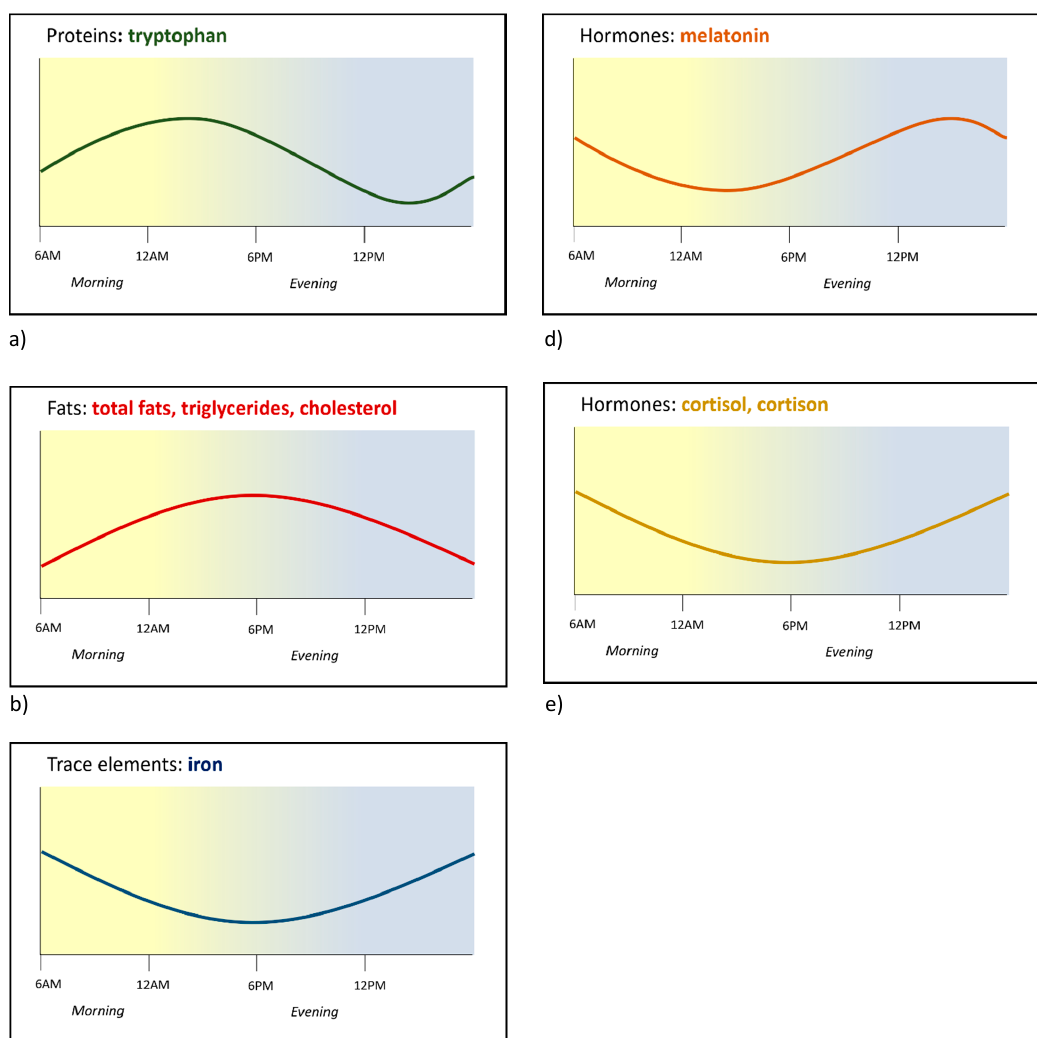
Figure 2. Circadian variation in human milk components. Schematic presentation of estimated circadian curves based on peak and trough values reported in the literature. Circadian variation curves are shown for the following components: ( a ) tryptophan [18,43], ( b ) total fats, triglycerides, cholesterol [25,32,47,48,50–53,55,56,58,59], ( c ) iron [53,67,70,71], ( d ) melatonin [41,82–89], and ( e ) glucocorticoids